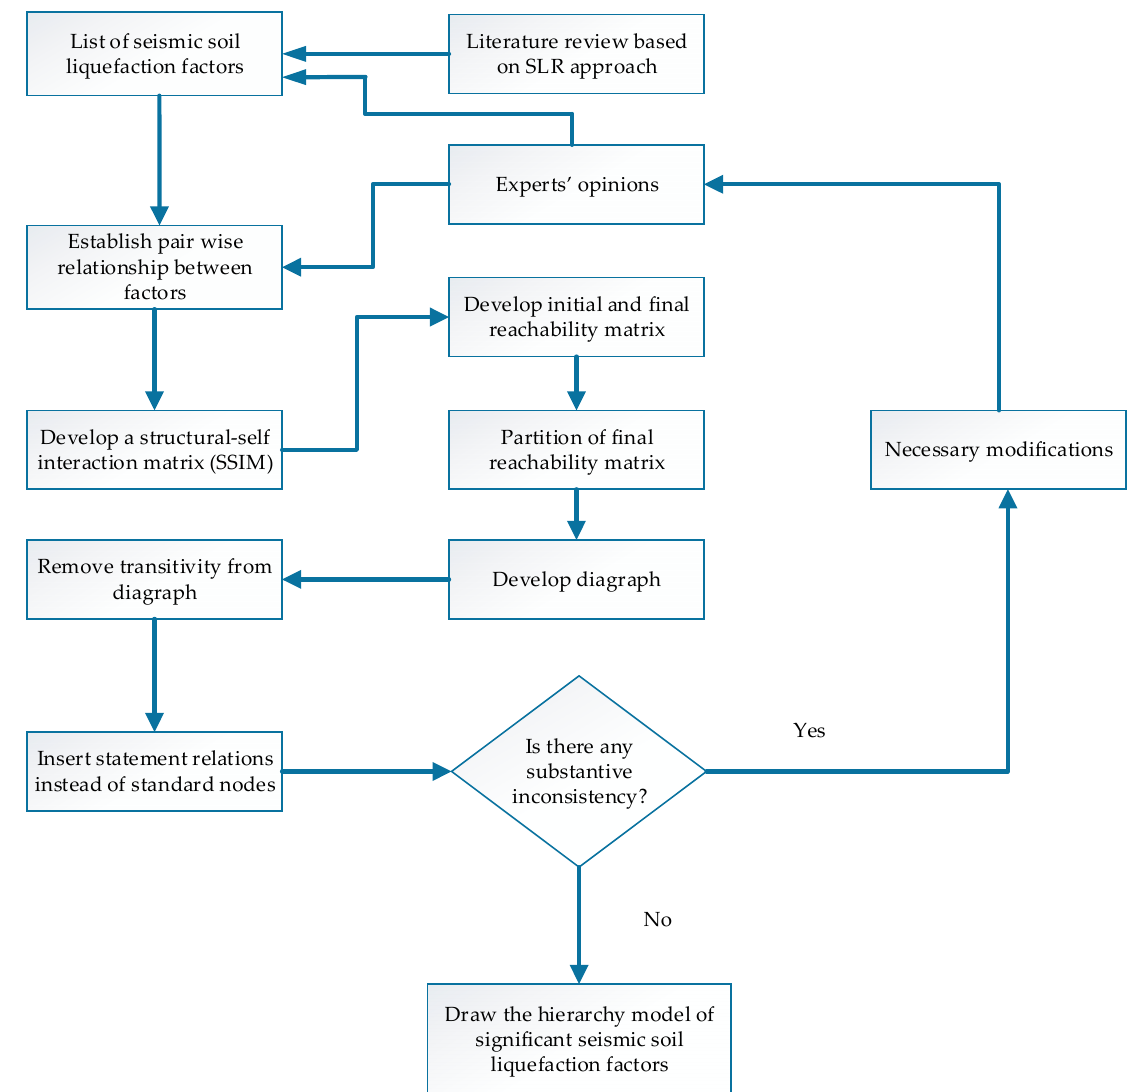
Figure 3. Interpretive structural modeling (ISM) methodology for analyzing soil liquefaction factors.